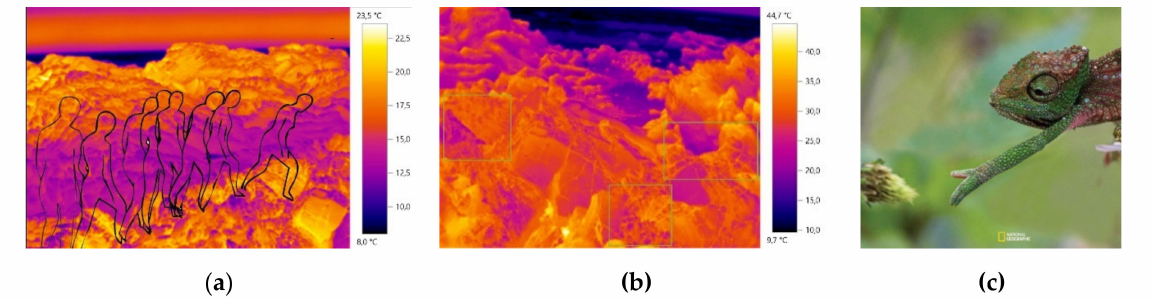
Figure 3. ( a ) Image of study of movement and silhouette; ( b ) Inspirational thermal image for the pattern modules M01 and M02; ( c ) Adapted chameleon-inspired photograph